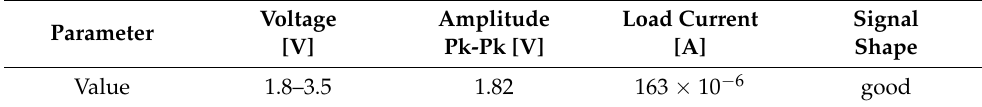
Figure 12. Acquired ECG signal with noise. Table 1. Operating values for the ECG sensor.